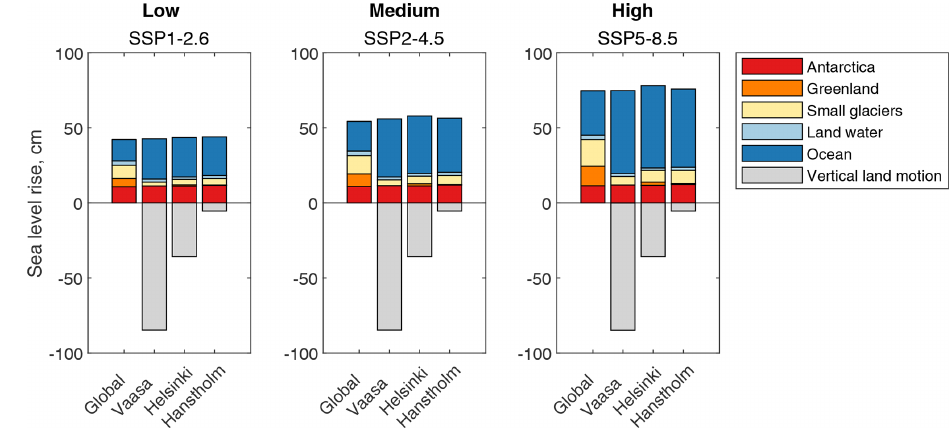
Figure 3. Median sea level rise projections of IPCC AR6 (medium confidence, 2100 relative to 1995–2014) divided into different compo- nents, for three emission scenarios. The ocean component includes thermal expansion and ocean dynamical effects. The global projection is shown together with three local projections: Vaasa and Helsinki at the Finnish coast, Hanstholm at the North Sea coast of Denmark.